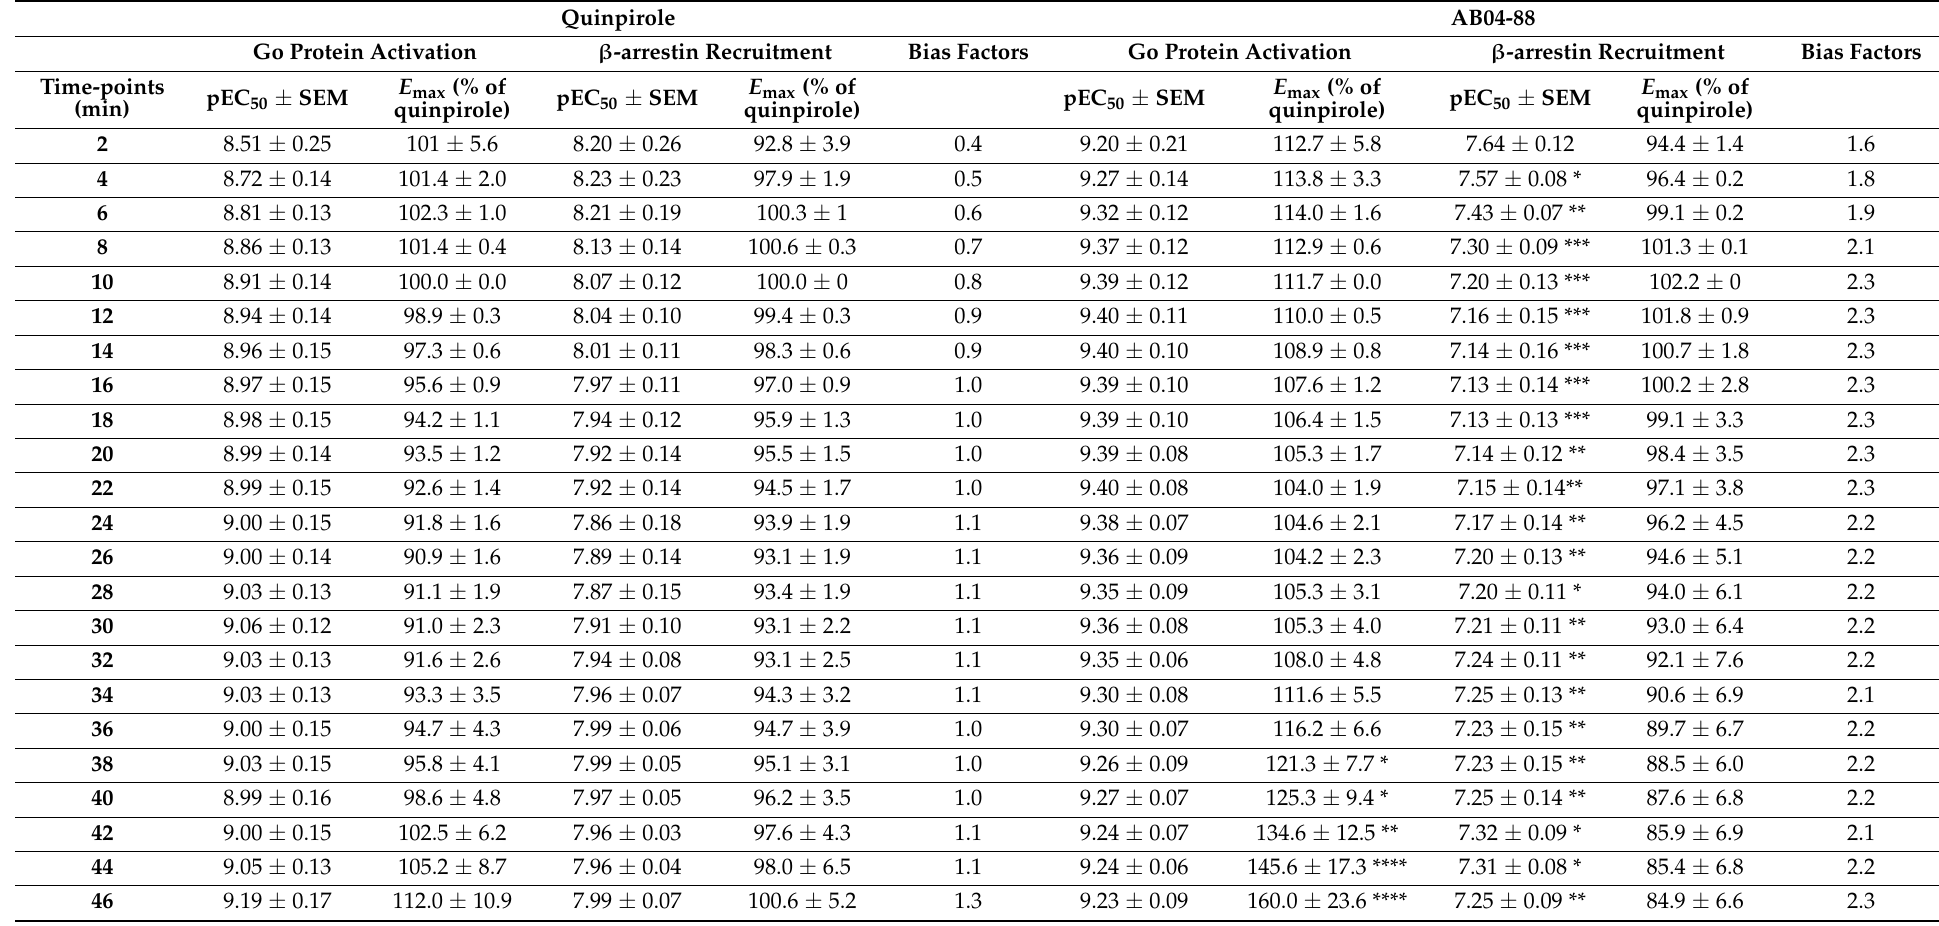
Table 4. Time dependent D3R pharmacological profile of quinpirole and